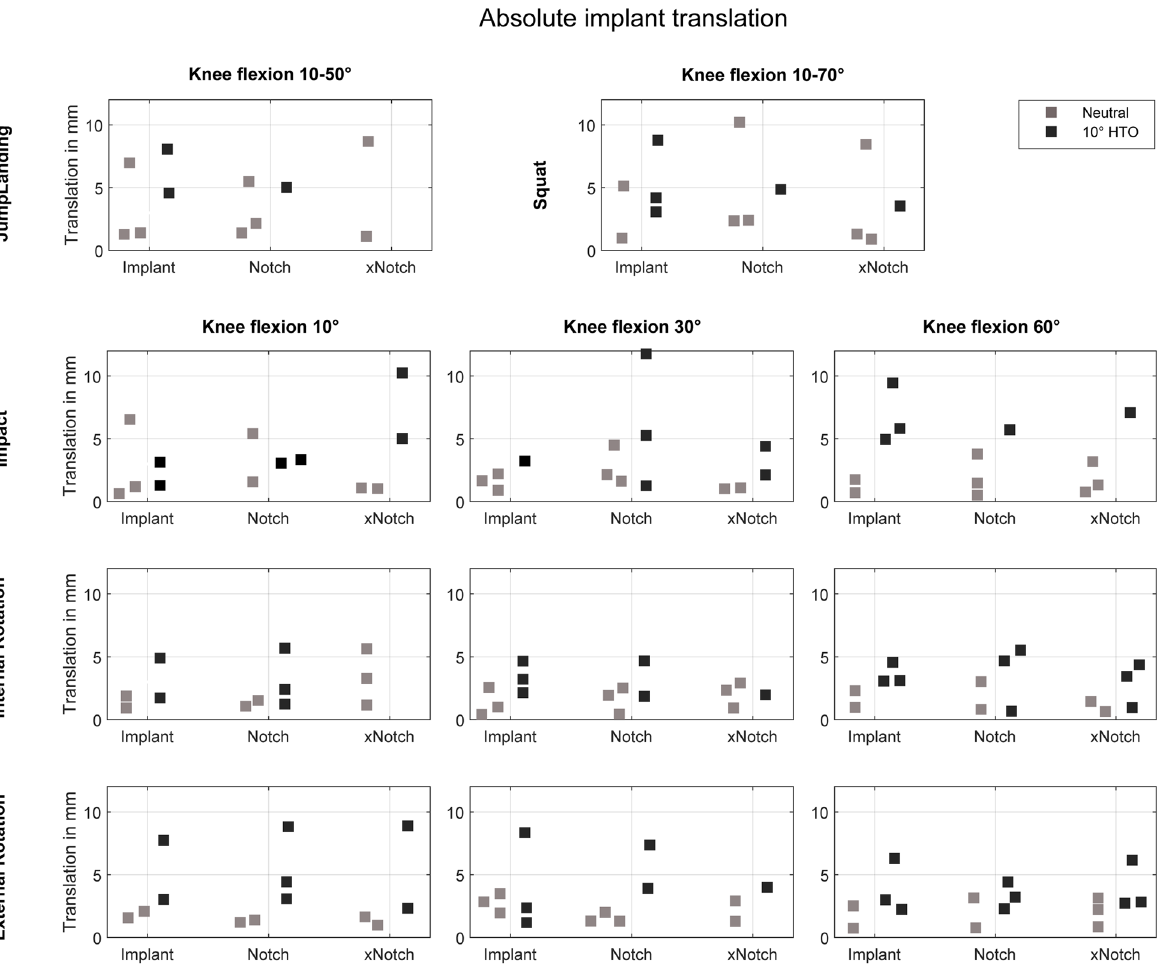
Fig. 5 Maximum absolute translation in mm of the device during the four different exercises and three different knee states: intact knee joint (inserted device, no notchplasty), conventional notchplasty and extended notchplasty. Coloured distinction between the neutral leg axis position (grey) and the valgus alignment shift